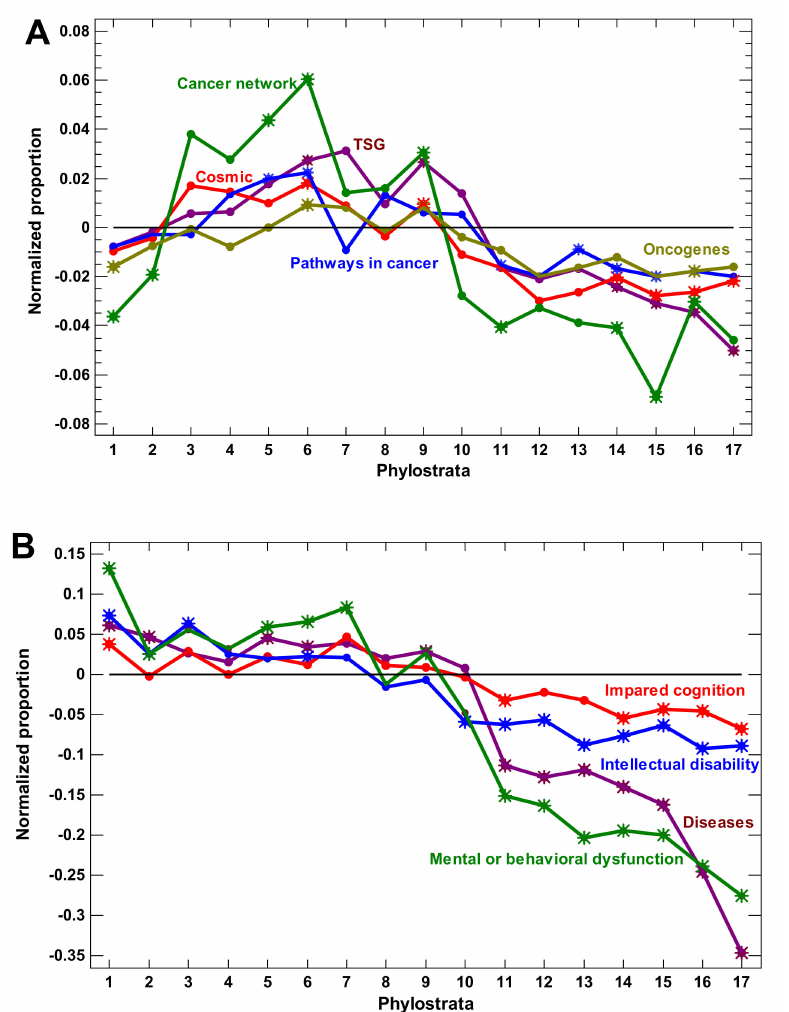
Figure 5. Phylostratic course of normalized gene proportions for different gene groups (baselines for all groups are set to zero). ( A ) Cancer-related genes. ( B ) Disease-related genes. Asterisks show significant enrichment (if above baseline) or underrepresentation (below baseline).